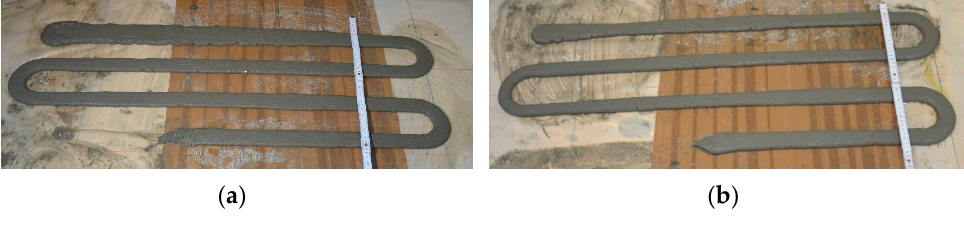
Figure 8. Print quality test: ( a ) OR0; ( b ) OR100.